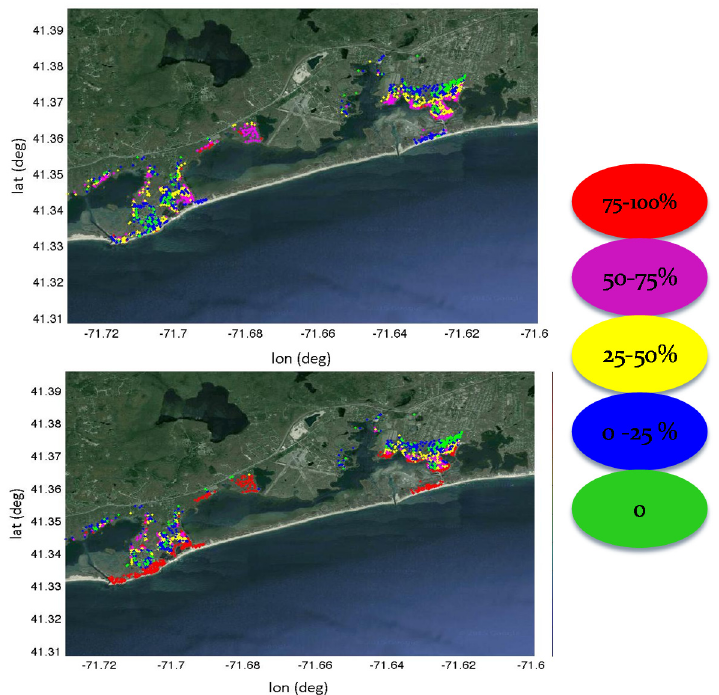
Figure 10. Percent damage by structure for Charlestown, RI for 100 year storm, dune intact (upper panel) and dune eroded (lower panel). The color legend for the percent damage is shown to the right of the figure and also included on the lower right corner of the figure.